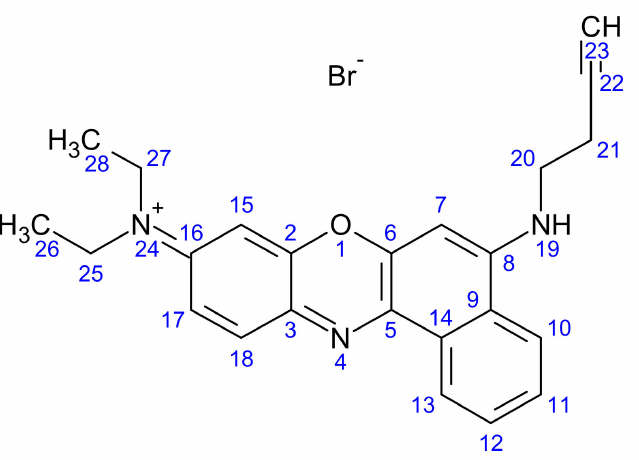
Figure 6. Structure of but-3-yn-1-yl (N 9 ,N 9 -diethyl-9H-benzo[ a ]phenoxazine-5,9-diamine) bromide